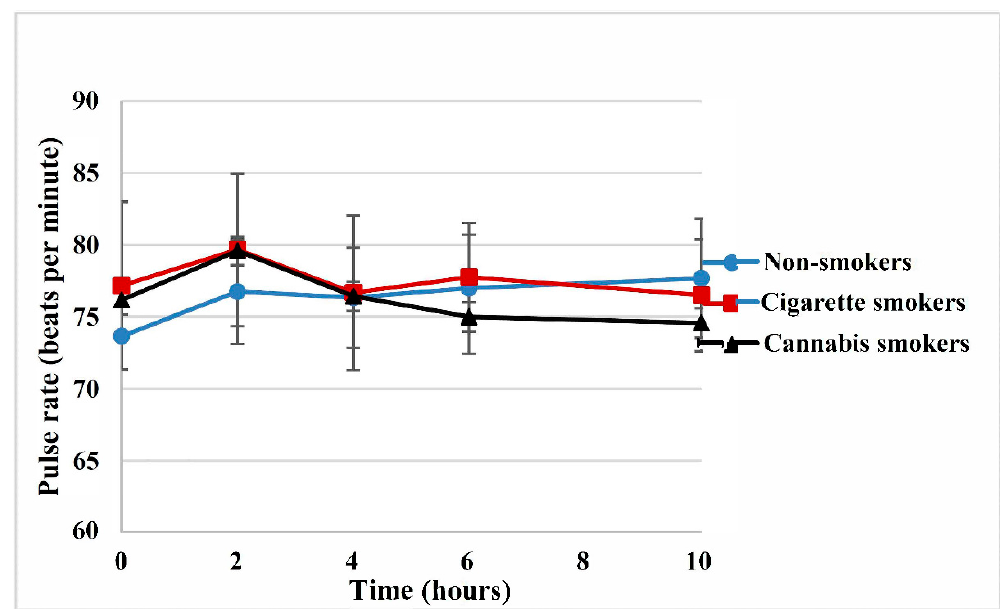
Figure 3. Mean blood pressure (systolic/diastolic) co-plot with mean sildenafil plasma concentration versus time after the oral administration of a single 50 mg dose of sildenafil tablets in each group: ( a ) non-smokers; ( b ) cigarette smokers; ( c ) cannabis smokers.